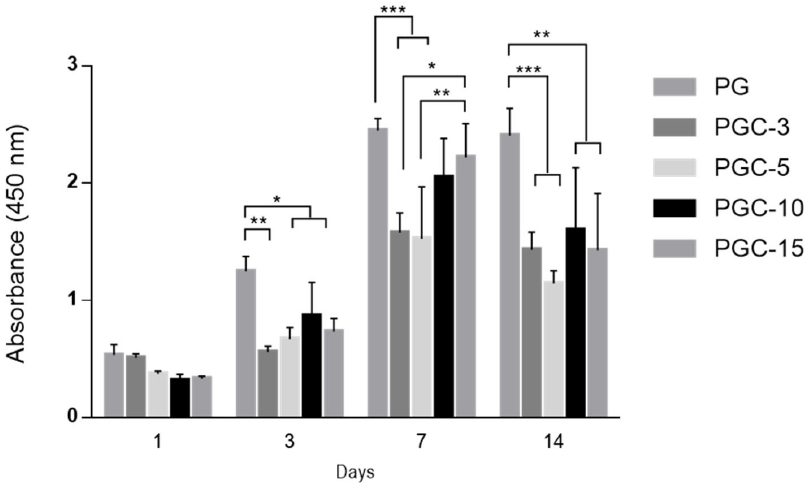
Figure 8. Cell viability of L929 cells on different samples after 1, 3, 7, and 14 days. Results are presented as mean ± standard derivation * p < 0.05, ** p < 0.01, *** p < 0.001.